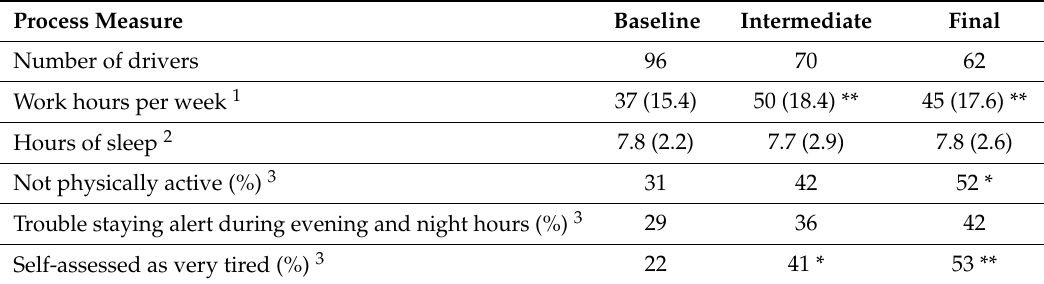
Table 3. Values (mean ± SD or %) for the process measures for the entire group of drivers at the baseline, intermediate, and final measurements.